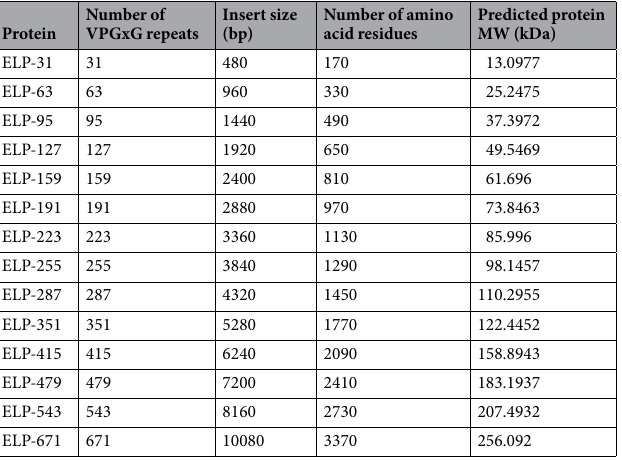
Table 1. ELP constructs, their coding sequence size, and predicted protein molecular